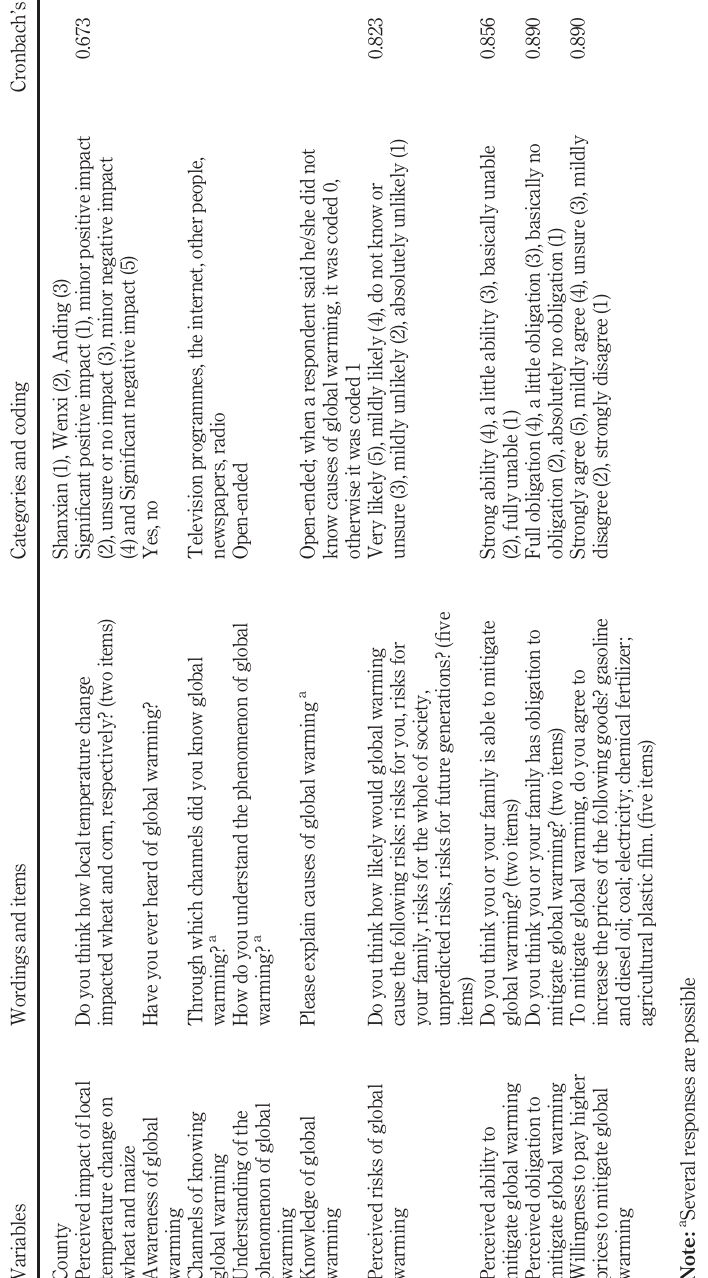
Table II. Variables and